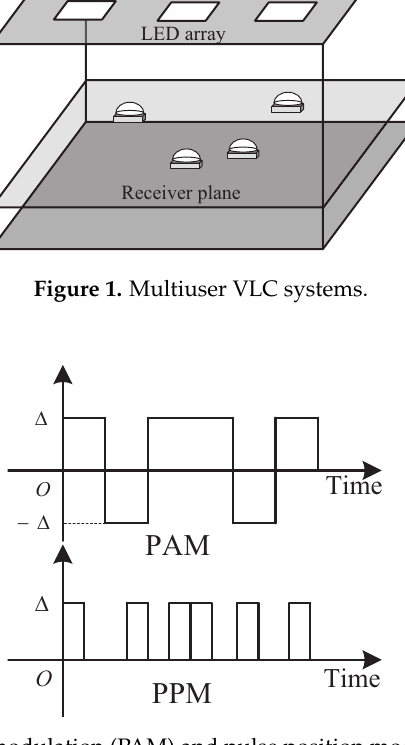
Figure 2. Pulse amplitude modulation (PAM) and pulse position modulation (PPM)